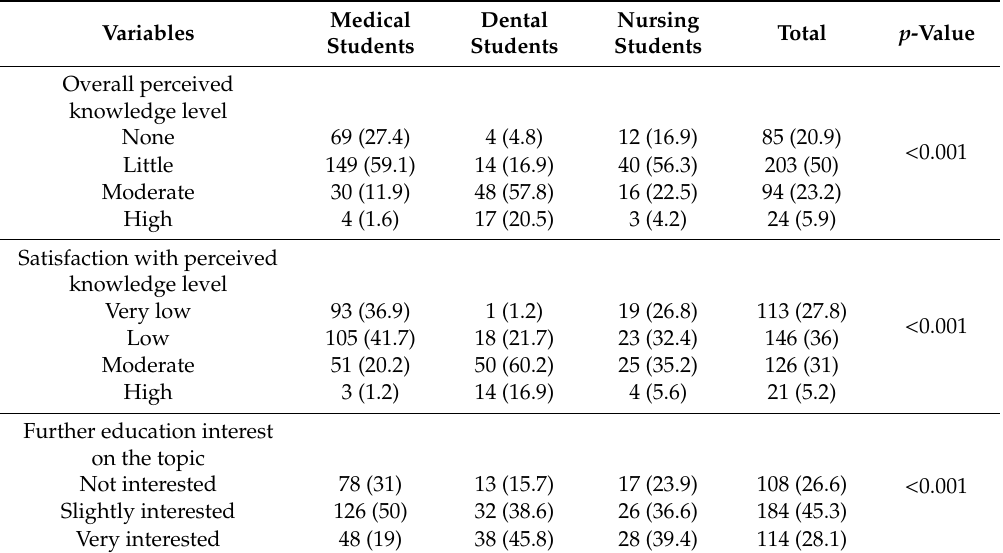
Table 3. Responses to part three of the questionnaire ( n (%)).